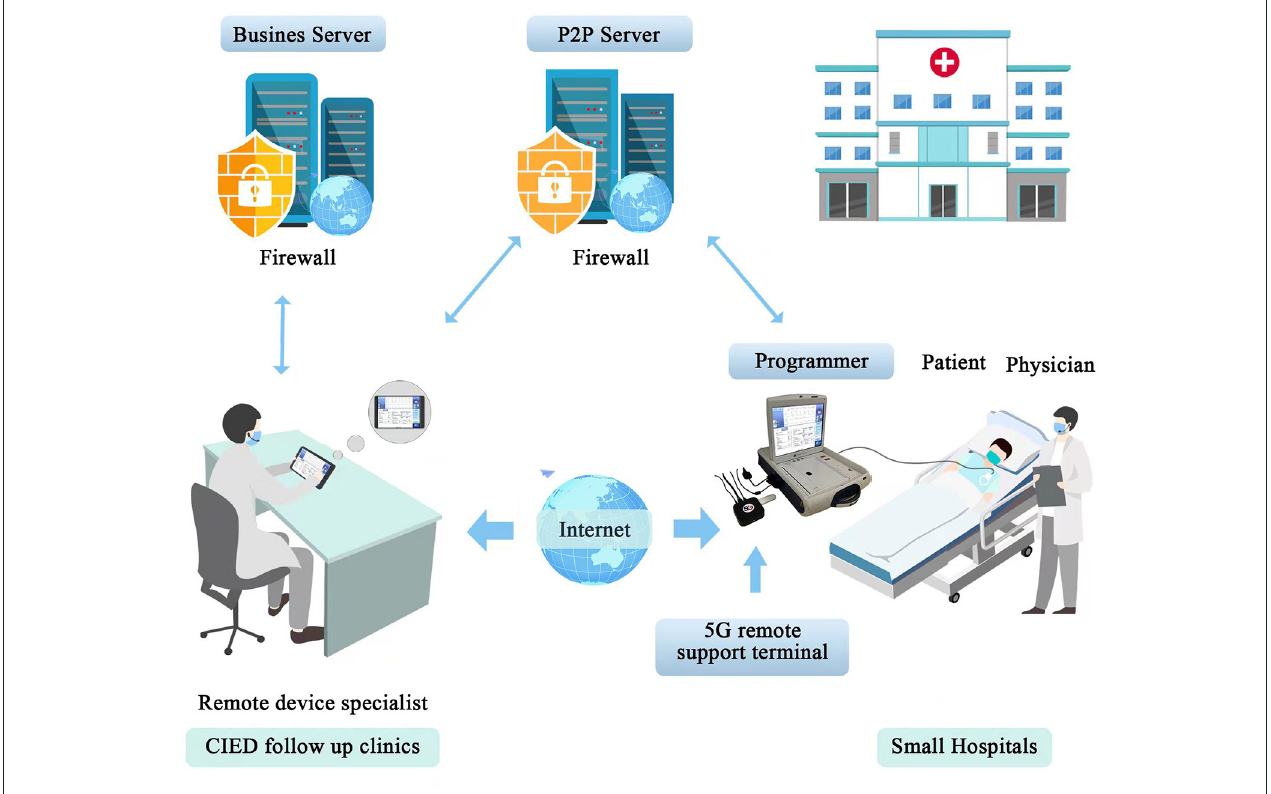
FIGURE 1 | The organization of a realtime remote programming system. The 5G-cloud follow up platform comprises a 5G remote support terminal that is externally connected to the programmer, a PAD installed with a 5G-cloud follow up application, and a remote service system deployed on cloud servers. The P2P Server is used to establish the communication between the 5G remote support terminal and the 5G-cloud follow-up application when the designated account is logged in. Then the 5G remote support terminal is directly connected with the 5G-cloud follow-up application via internet. No network or software is required for the on-site programmer. Remote control of the on-site programmer can be realized by simply connecting to the 5G remote support terminal and using simulated mouse and keyboard information. No direct data interact between the computer and the on-site programmer. The Business Server is used for the second verification to establish remote connection and storing audit logs. This system enables follow up clinics could provide realtime remote programming of CIEDs for small hospitals (primary medical and health care institutions) that lack follow up clinics or device specialists. The application of this system in a hospital includes expeditious remote device programming in different scenarios, such as urgent MR scanning, lead testing during the CIED implantation procedure, and patients in the emergency department. PAD indicates tablet personal computer; CIEDs, cardiac implantable electronic devices; P2P Server, Pointer-to-Pointer Server.